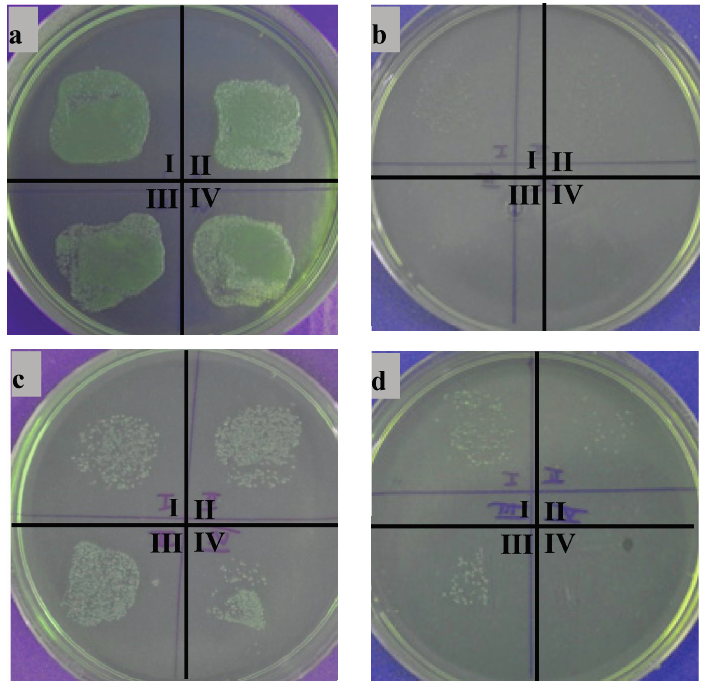
Figure 6. Results of antibacterial studies on different samples: ( a ) pure stainless steel; ( b ) chitosan; ( c ) chitosan/BG; and ( d ) chitosan/nano